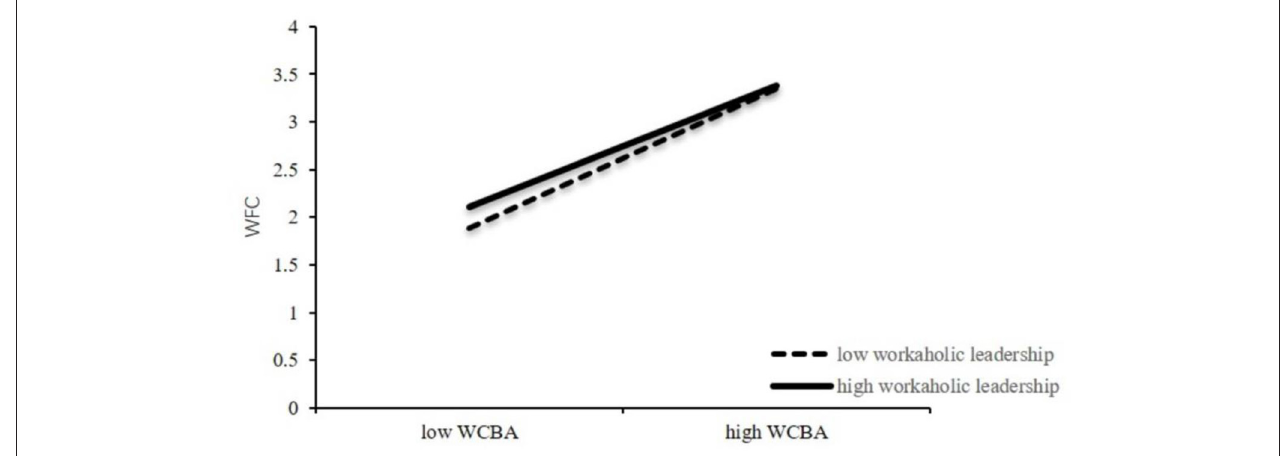
FIGURE 2 | The moderating effects of leader workaholism on WCBA and WFC.